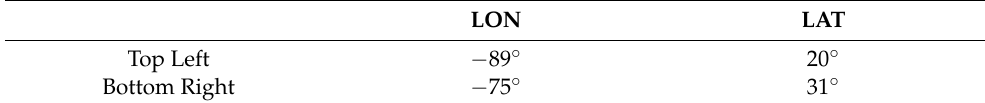
Table 2. Selected data